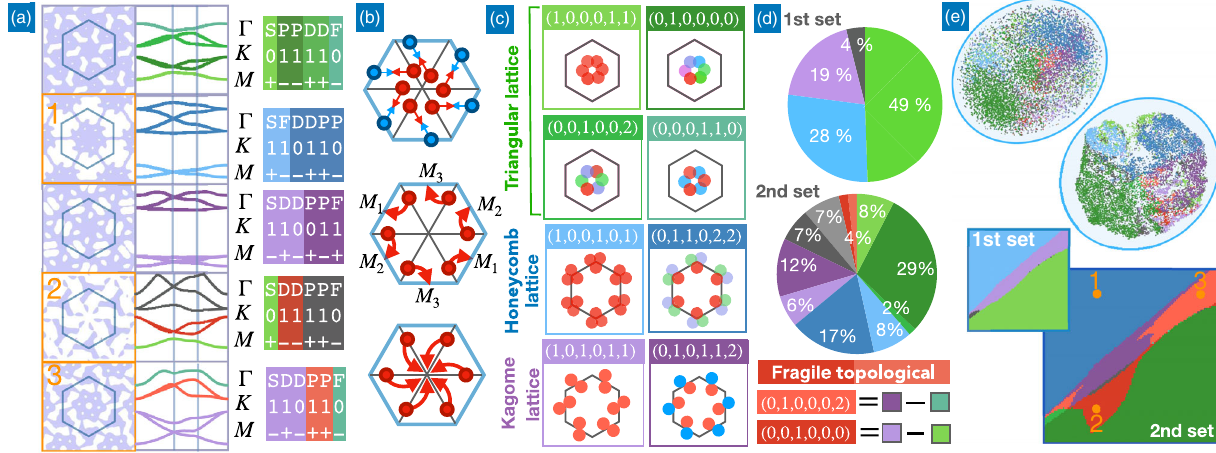
FIG. 3. Using the NN to explore the topological properties of large sets of potentials. (a) Examples of randomly generated potentials and the band structure predicted by the NN. The tables indicate the irreps predicted by the NN for each of the first six bands. (b) Possible pathway leading to the annihilation of two (one) sextuplets of Dirac cones. For one sextuplet, this process is possible only at Γ or M . (c) The EBRs for the wallpaper group p 6 . The sketches depict the “ Wyckoff ” positions and point symmetry of the underlying orbitals. ; n ; n ; n ; n 0 ; n The “ occupations ” n in the “ symmetry fingerprint ” ð n Þ count the number of (pairs of) Bloch waves for the i s p d f þ 1 means that there is one pair of p waves at Γ . (d) Distribution of (quasi-) BRs for the first (upper chart) corresponding irreps; e.g., n p ¼ and second (lower chart) set of bands. The light gray slice represents sets of bands that cannot be classified based on the first six bands only but are likely to be composite BRs; see Appendix I. All other composite BRs are grouped in the dark gray slice. (e) t-SNE visualization [36], with each point representing a random potential (left) or the corresponding output (TB coefficients) of the NN (right); the latter visualization allows for improved clustering (colors indicate EBRs). (f) Phase map indicating EBR and fragile topology for the first (inset) and the second sets of bands. The parameter space interpolates between the potentials “ 1, ” “ 2, ” and “ 3 ” marked in panel (a), in terms of their underlying Fourier